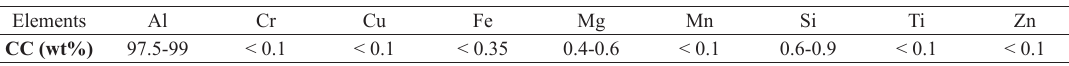
Table 1. Chemical composition (CC) for AA6005-T6 Aluminum alloy (wt%).